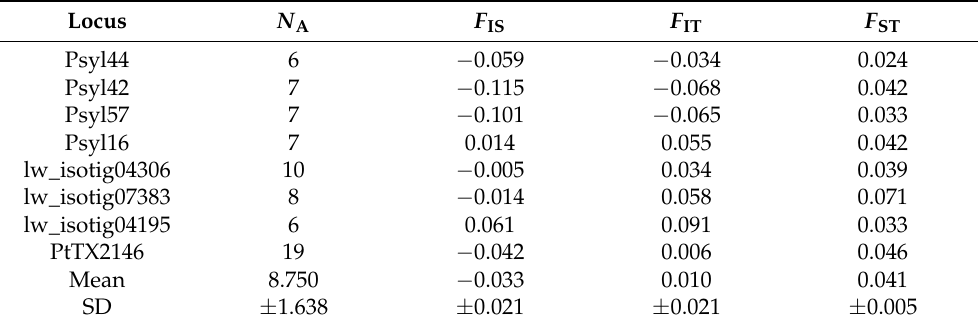
Table 2. Diversity statistics of the eight nuclear SSR loci across 406 Scots pine individuals. Locus N A F IS F IT F ST Psyl44 6